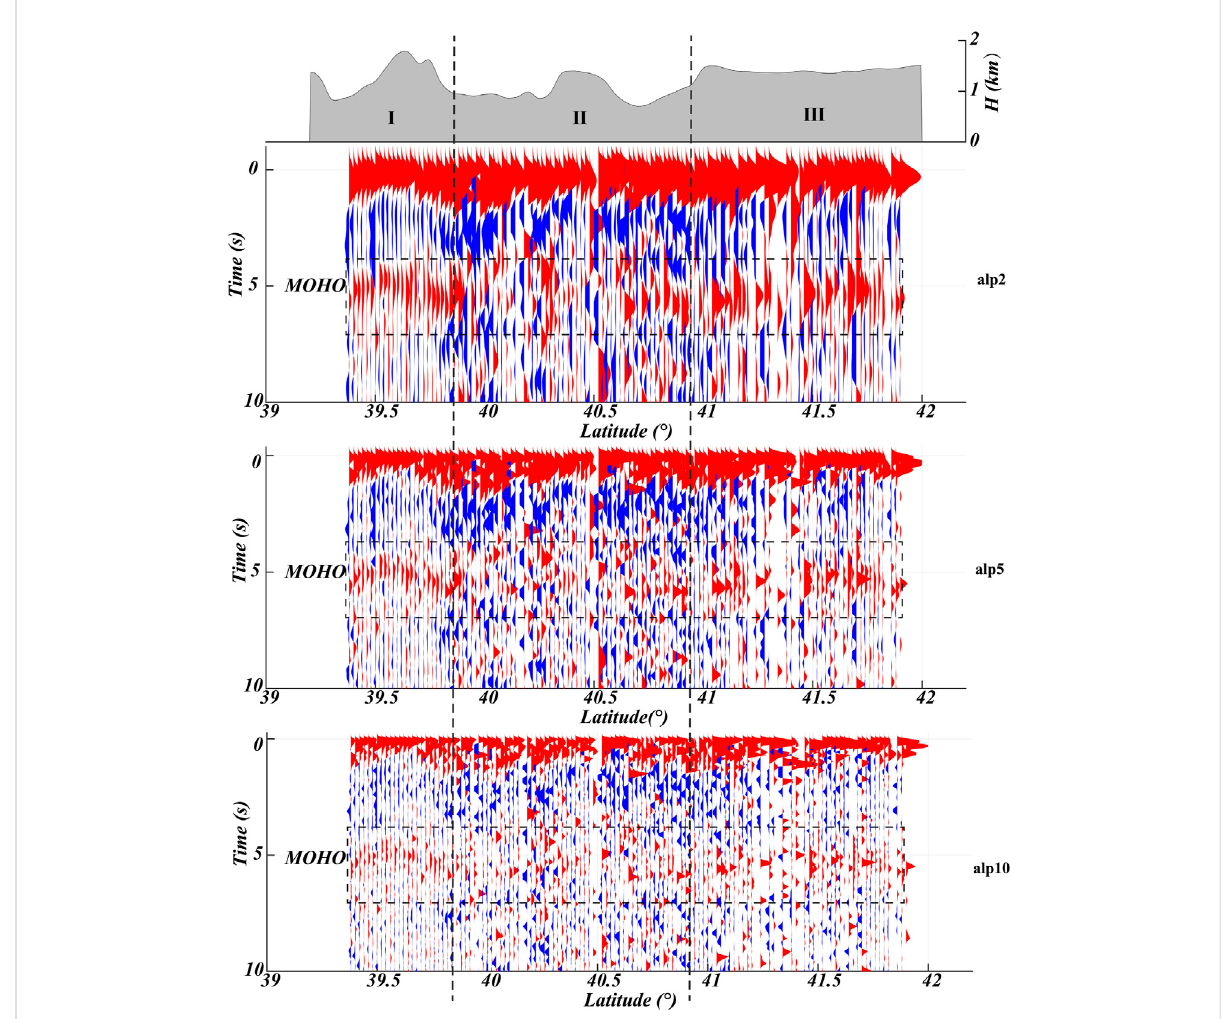
FIGURE 3 Stacking pro fi le of receiver functions with different Gaussian fi lter factors (alp). Alp = 2 (1.18 s pulse width), 5 (0.75 s pulse width), and 10 (0.53 s pulse width) were used to compare the signal stability.